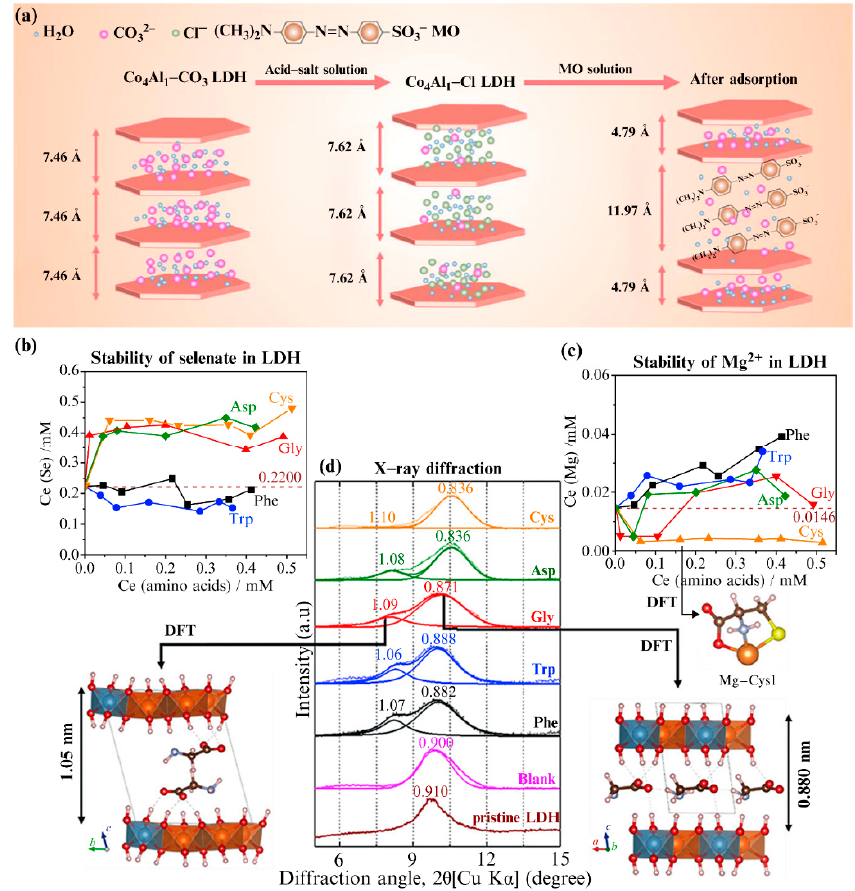
Figure 6. ( a ) Schematic illustration of the proposed “ion-exchange and expansion-extrusion” mech- anism for MO on Co 4 Al 1 − Cl LDH. Reproduced with permission from [28]. Plots of the released con- centrations of ( b ) SeO 42 − and ( c ) Mg 2+ ions after the reaction. ( d ) X-ray diffraction (XRD) patterns of the pristine Mg 2 Al − LDH and solid residues after the sorption reaction. Reproduced with permission from [45].